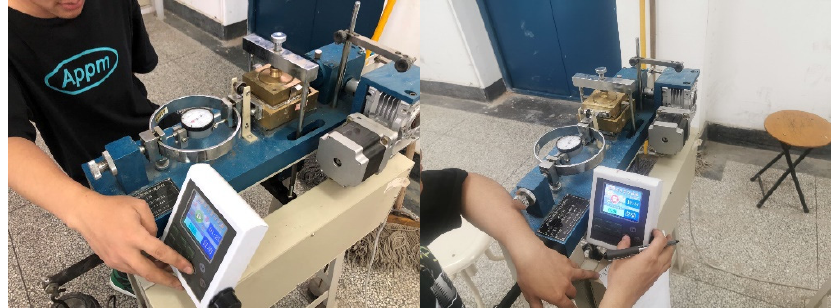
Figure 4. Direct shear test process.